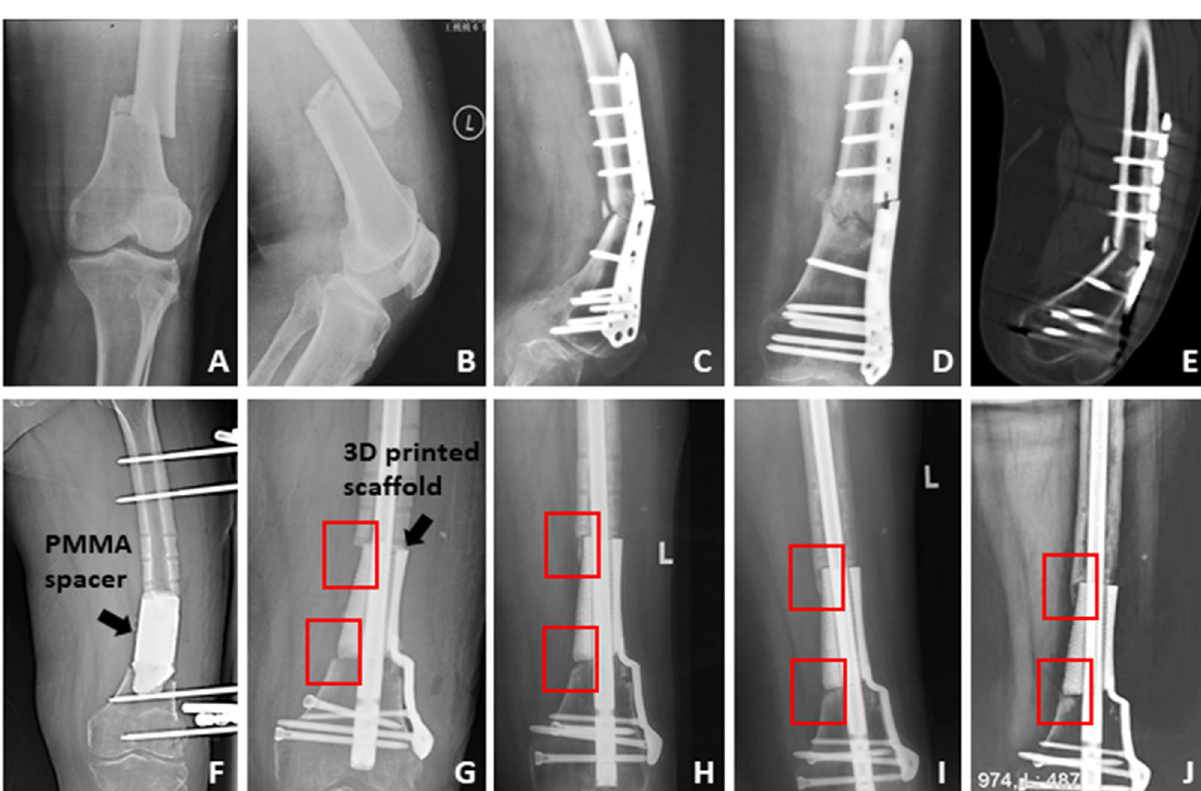
Fig. 2 The therapeutic process of the fi rst typical case. A , B The initial X-ray displayed the patient suffered the distal femoral displaced fracture; C – E The patient underwent the surgical treatment, and at 13 months after the initial surgery, X-ray and CT scan showed fracture nonunion and ends sclerosis, meanwhile, the plate had broken; F we cleared the sequestrums and fi lled a PMMA spacer into the femoral